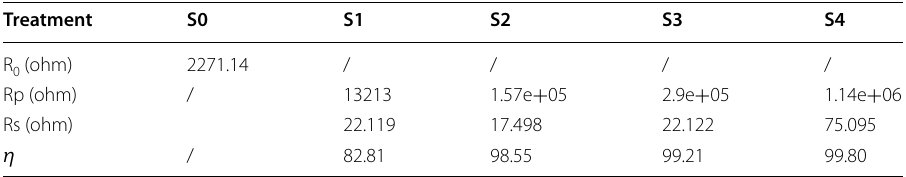
Table 3 Impedance parameters derived from EIS fitting curves for aluminum alloy 2030 in 3.5% NaCl for the different treatment baths